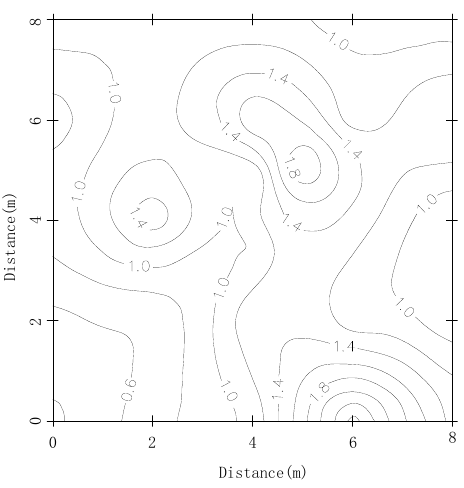
Figure 2. Contour map of scale factor δ .